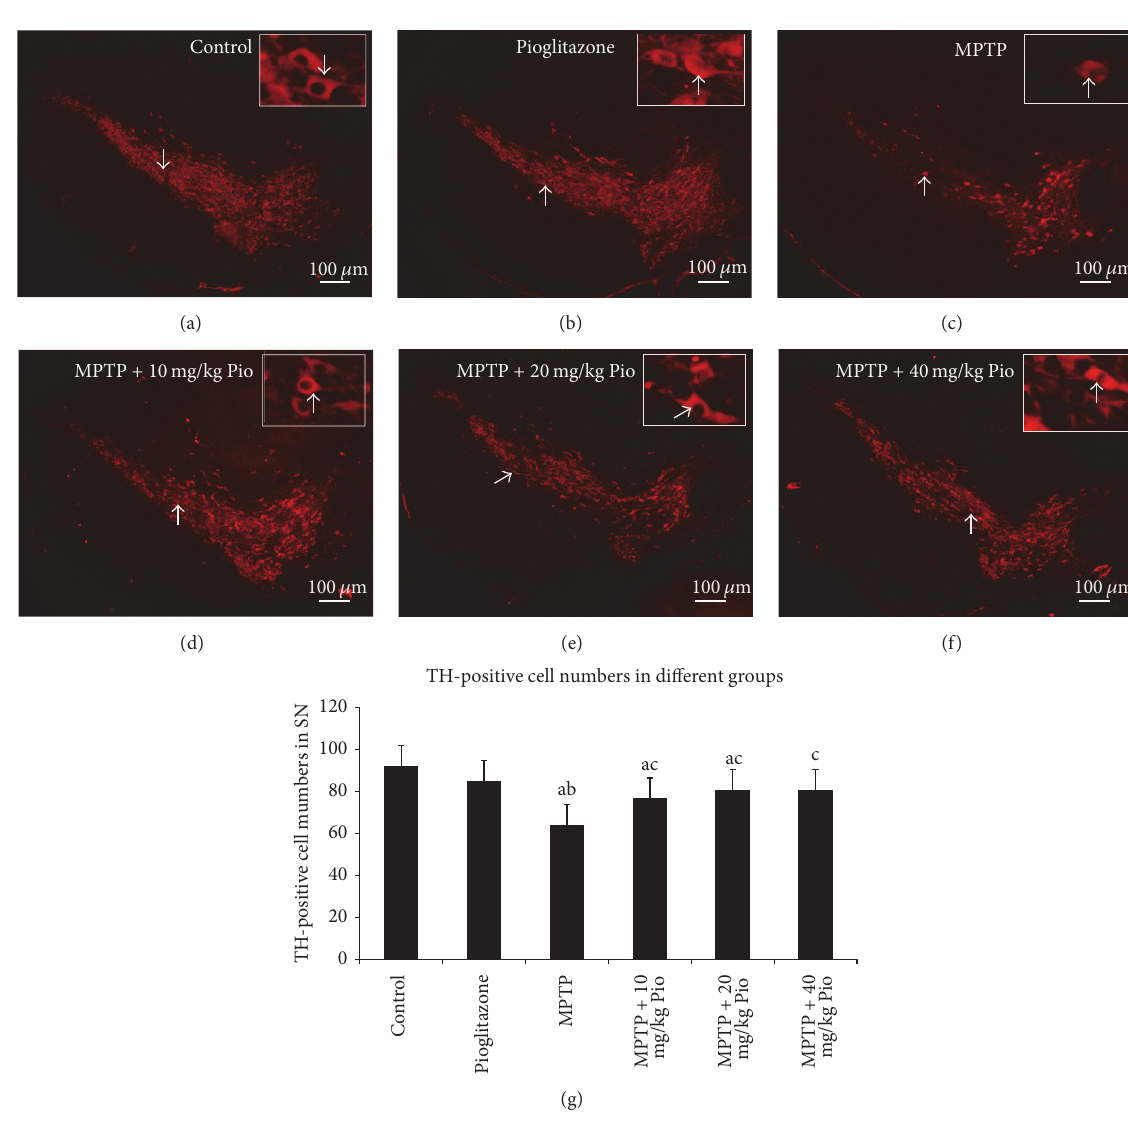
Figure 2: TH-positive neurons in different groups. “a” indicates 𝑃 < 0.05 , compared with control group; “b” indicates 𝑃 < 0.05 , compared with pioglitazone group; “c” indicates 𝑃 < 0.05 , compared with MPTP group. The bars in (a)–(f) indicate 100 𝜇 m; the arrows in each picture show the same